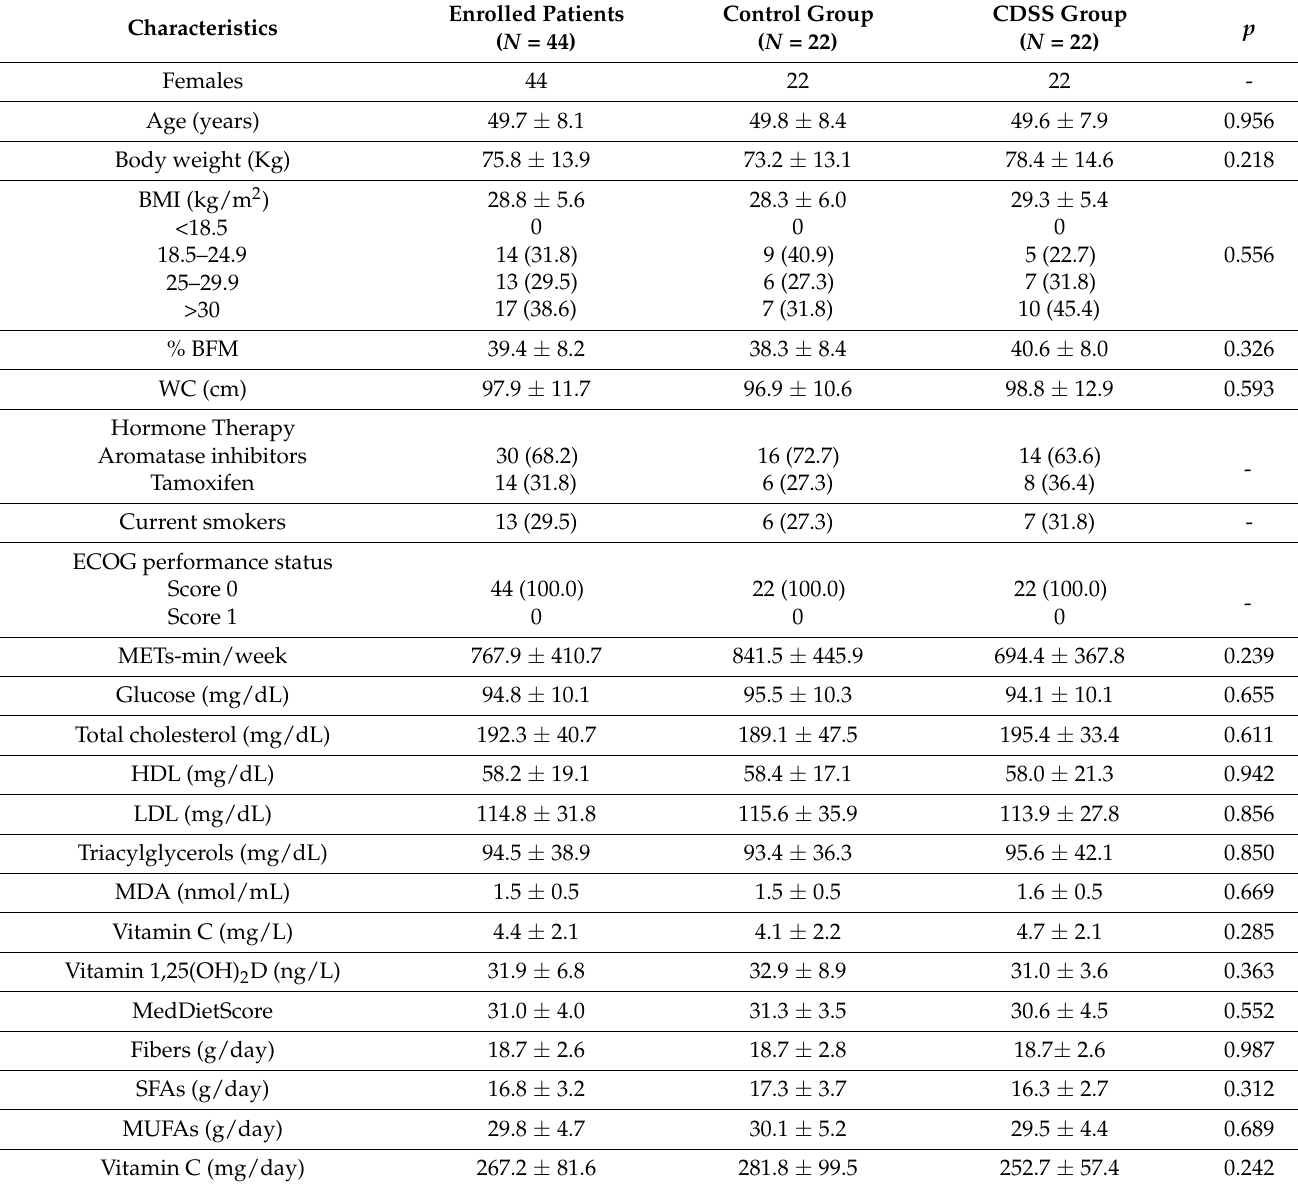
Table 1. Baseline characteristics of recruited BC